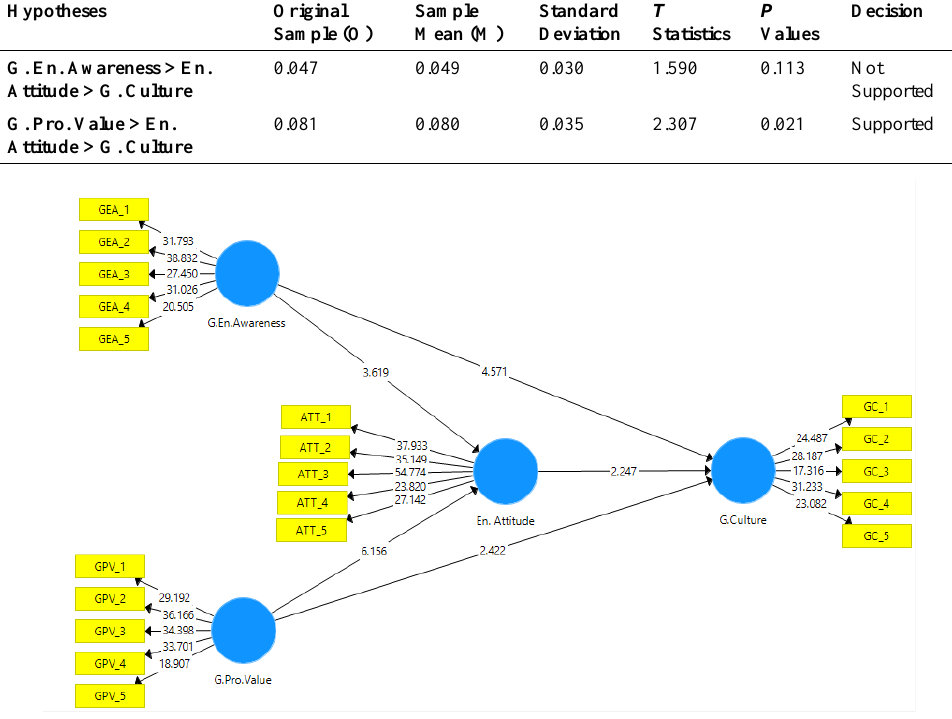
Fig. 3. Bootstrapping (Inner model with t